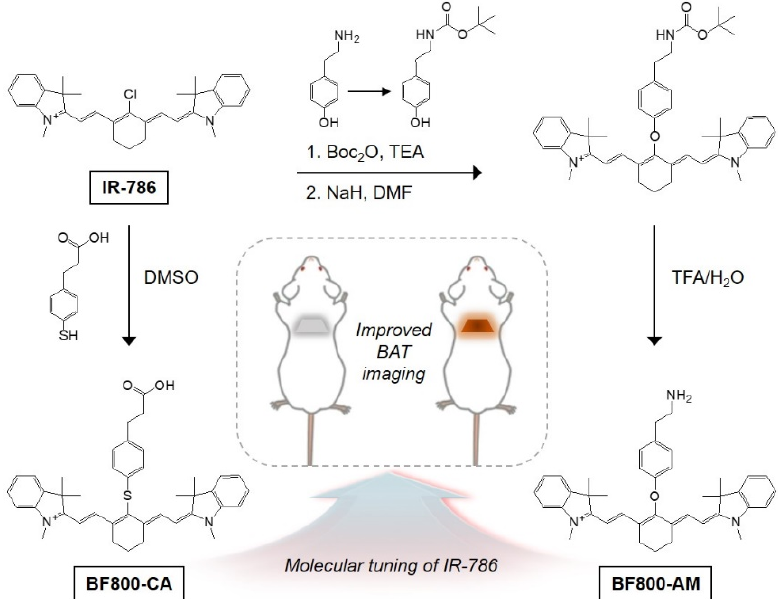
Figure 1. Synthetic scheme of BF800-AM and BF800-CA NIR dyes by the molecular tuning strategy for improved BAT imaging.